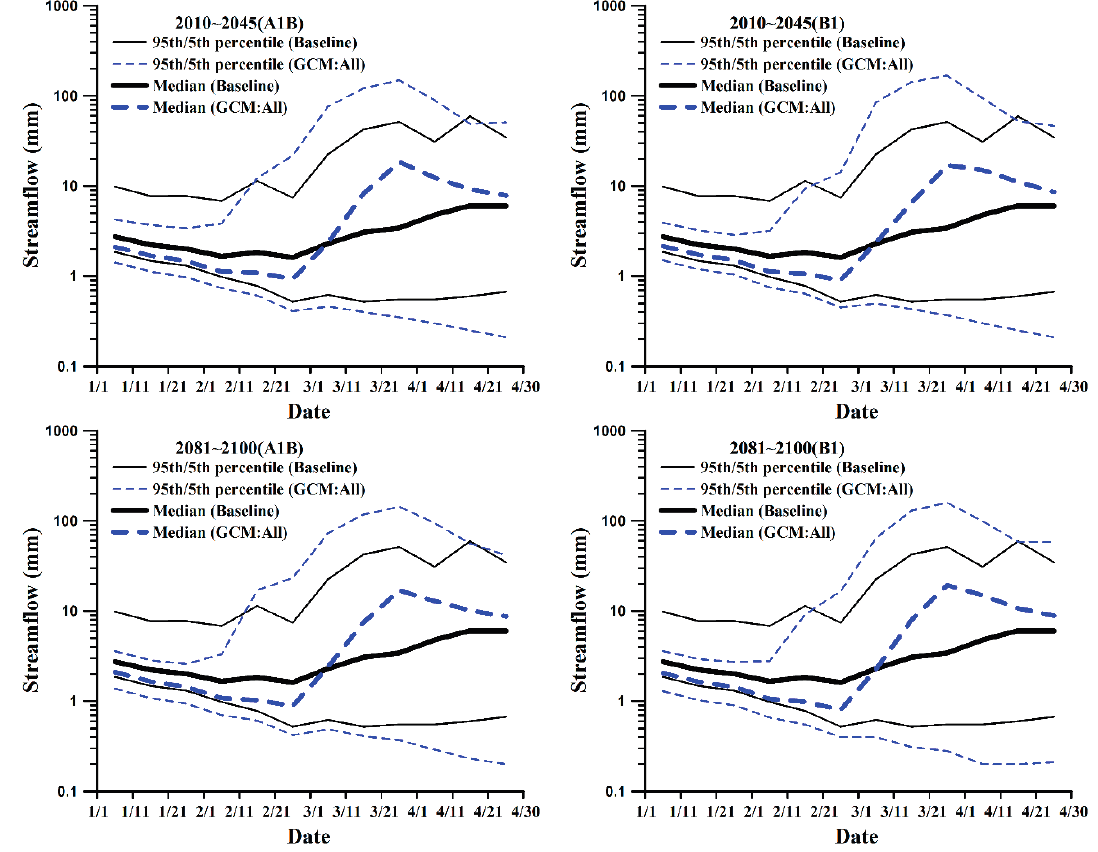
Figure 9. Hydrographs during the dry season. (Thick-solid line: the median during baseline period; Upper and lower thin-solid lines: the 95th and 5th percentiles during baseline period; the same notations are used for scenario data by thick-dash and thin dash